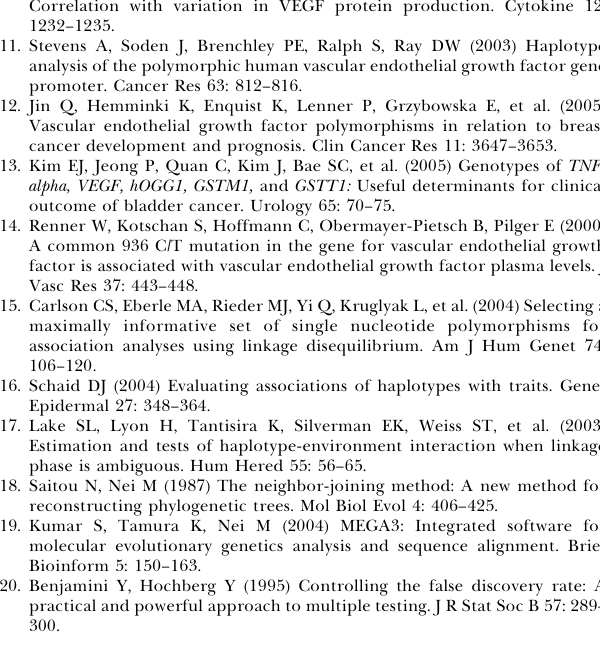
Table S2. SNP-Based Analyses: Association between Bladder Cancer Risk and SNPs with a p -value from a Trend Test or a 2-df LRT (cid:4) 0.01 in the Spanish Bladder Cancer Study Table S3. Association between Common Variants in VEGF and Bladder Cancer Risk in the Spanish Bladder Cancer Study Table S4. Genotype Cell Counts for Cases and Controls Table S5. Modification of the Association between Selected Variants in VEGF and Bladder Cancer Risk by Age, Gender, Smoking Status, Family History of Cancer, NAT2 and GSTM1